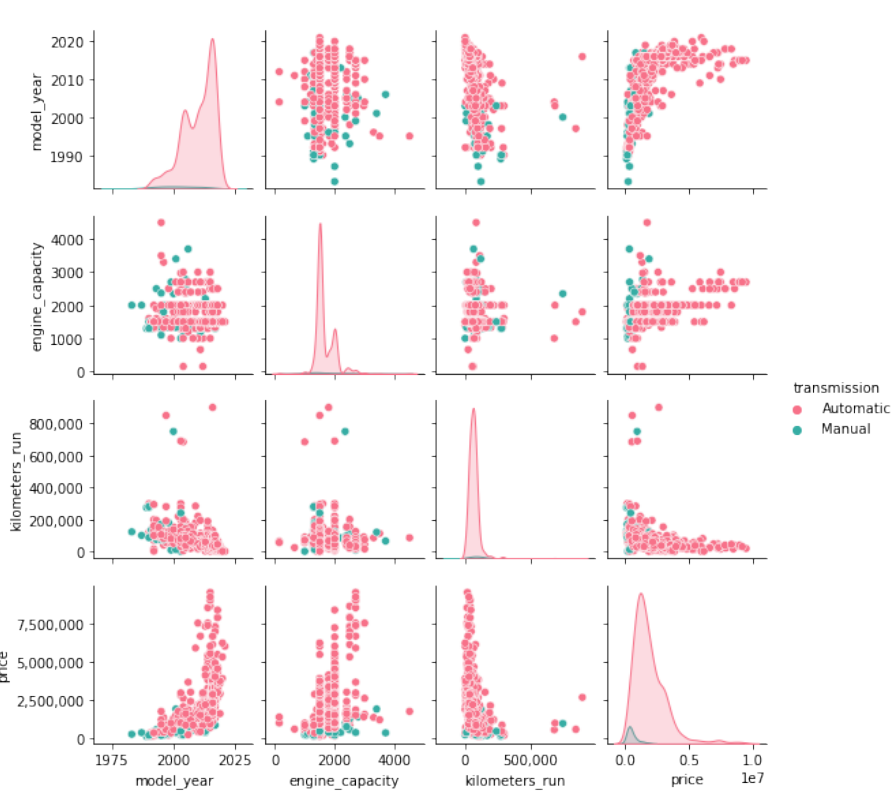
Figure 11. Pair plot of automatic and manual